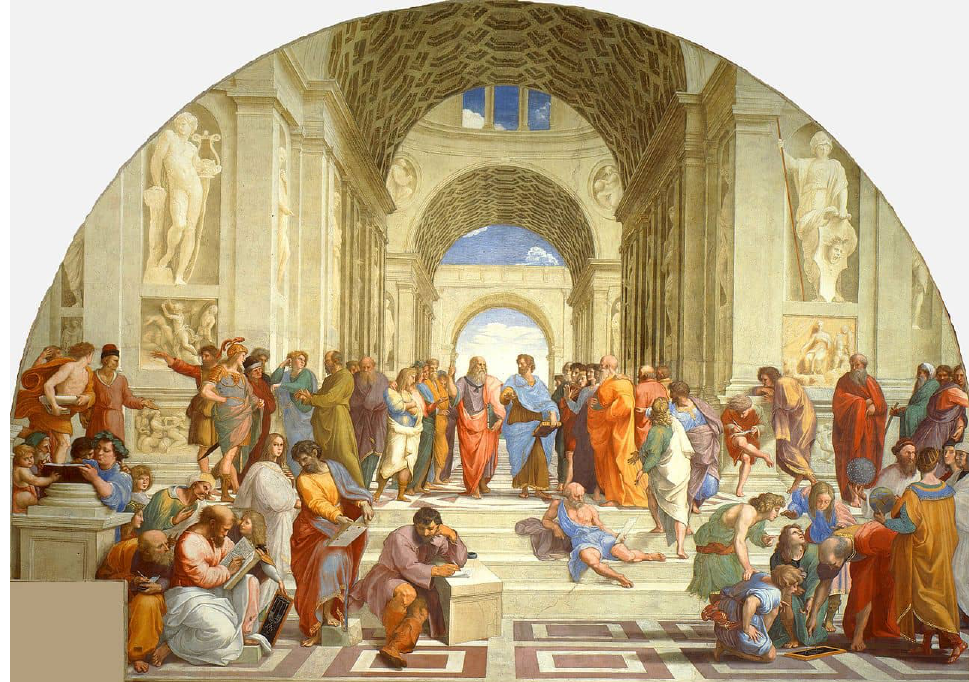
Figure 2. The School of Athens (Italian: Scuola di Atene ) is a fresco by Raphael, which depicts the concept of philosophy. The most famous philosophers of ancient times move within an imposing Renaissance architecture, which was inspired by Bramante’s project for the renewal of the early Christian basilica of St Peter. Some of these are easily recognizable. In the center, Plato points upwards with a finger and holds his book Timeus in his hand, flanked by Aristotle with Ethics ; Pythagoras is shown in the foreground intending on explaining the diatessaron. Diogenes is lying on the stairs with a dish, while the pessimist philosopher, Heracleitus, a portrait of Michelangelo, is leaning against a block of marble, writing on a sheet of paper. Michelangelo was in those years executing the paintings in the nearby Sistine Chapel. On the right, we see Euclid, who is teaching geometry to his pupils; Zoroaster holding the heavenly sphere; and Ptolemy holding the earthly sphere. The personage on the extreme right with the black beret is a self-portrait of